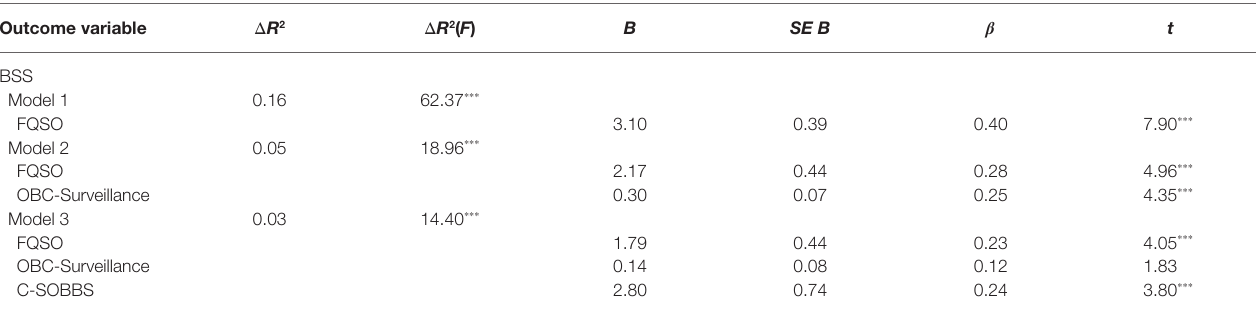
TABLE 4 | Incremental validity of C-SOBBS relative to the FQSO and OBC-surveillance scale. Outcome